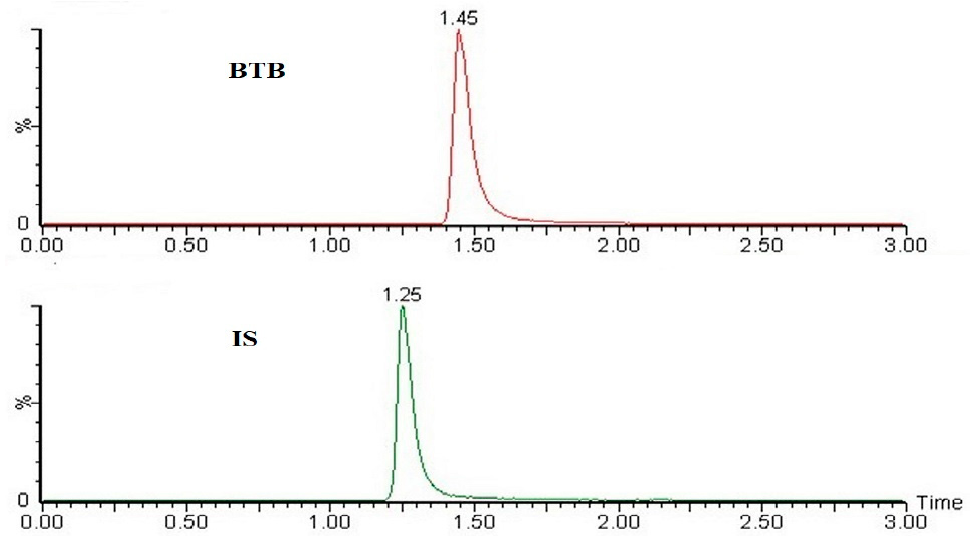
Figure 7. Representative MRM chromatogram of BTB and IS at T max after oral administration of 1 mg/kg of B-PLN4 formulation in rats.